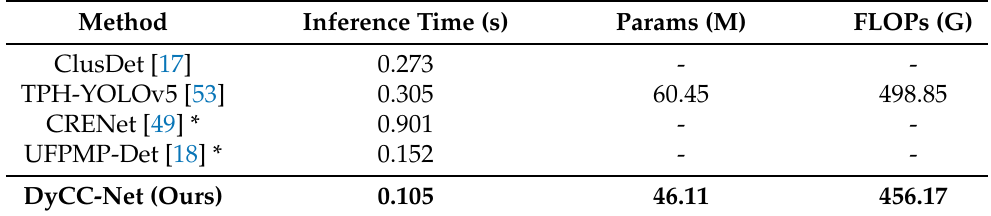
Table 6. Comparison of different methods in inference time cost (s) on VisDrone. ‘-’ denotes that the corresponding experimental statistics are not available. ‘*’ means that authors do not release their source